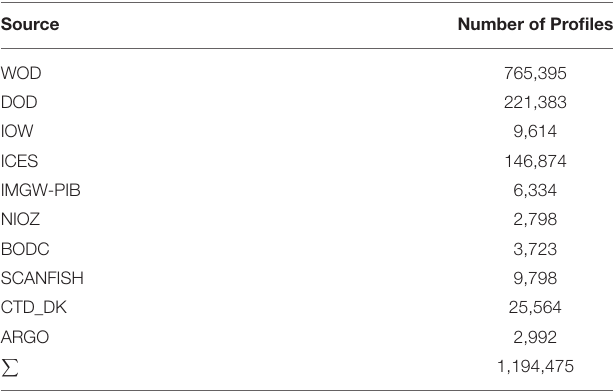
TABLE 1 | Number of remaining BNSChydr profiles after sorting of